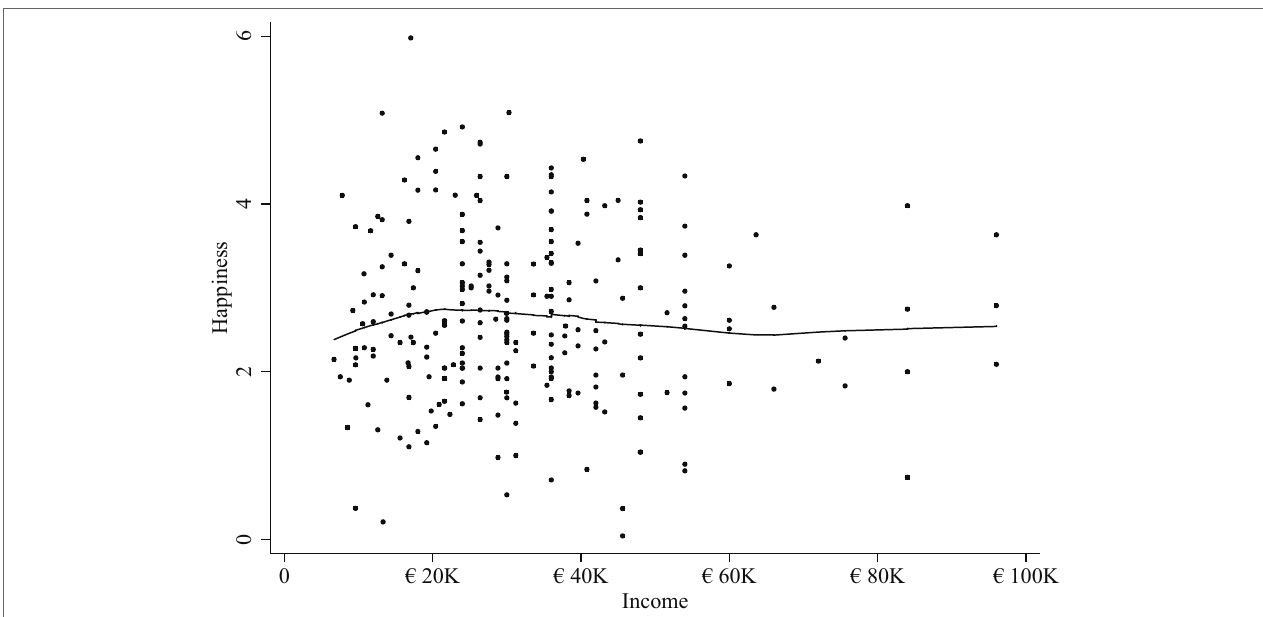
FIGURE 5 | Results of local linear “lowess” regression from GSOEP Experience Sampling Methodology (ESM) data with happiness as the outcome and continuous annual income as the explanatory